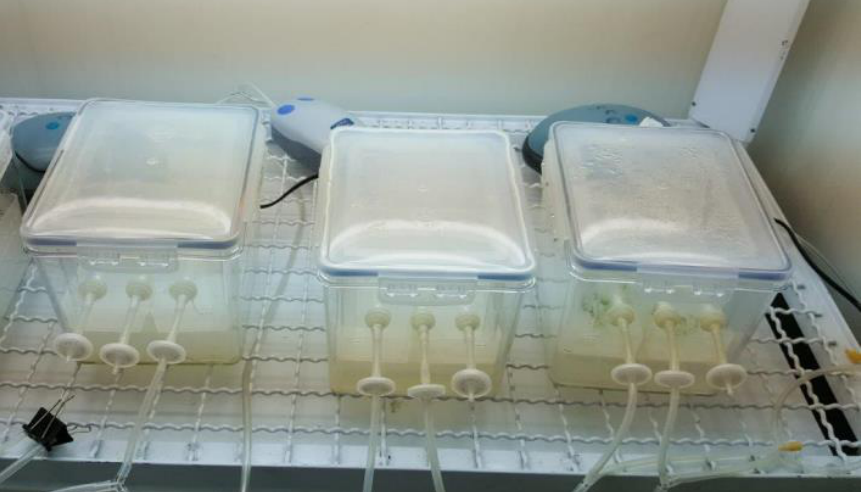
Figure 1. PlantForm bioreactor TIS model consisting of one container.